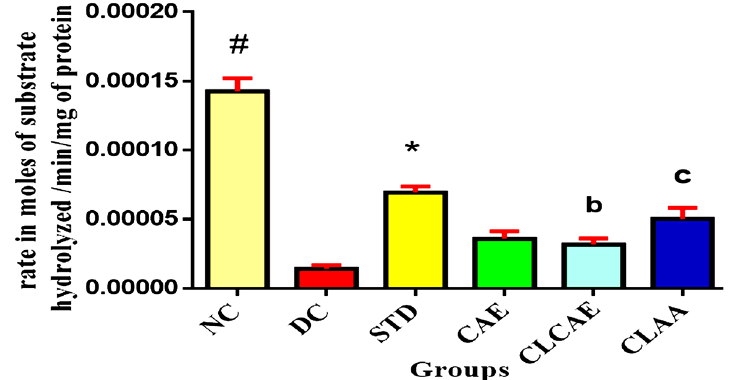
Figure 11. AChE assessment study of CLCAE, CLAA. Note (bottom): Data represented as mean (cid:3) SD. Statistical analysiswasperformedonewayANOVAfollowedbyBonferronimultiplecomparisontests.##p<0.001,* p<0.01,bp < 0.1, c< 0.05 when compared to disease control (n=6 ).